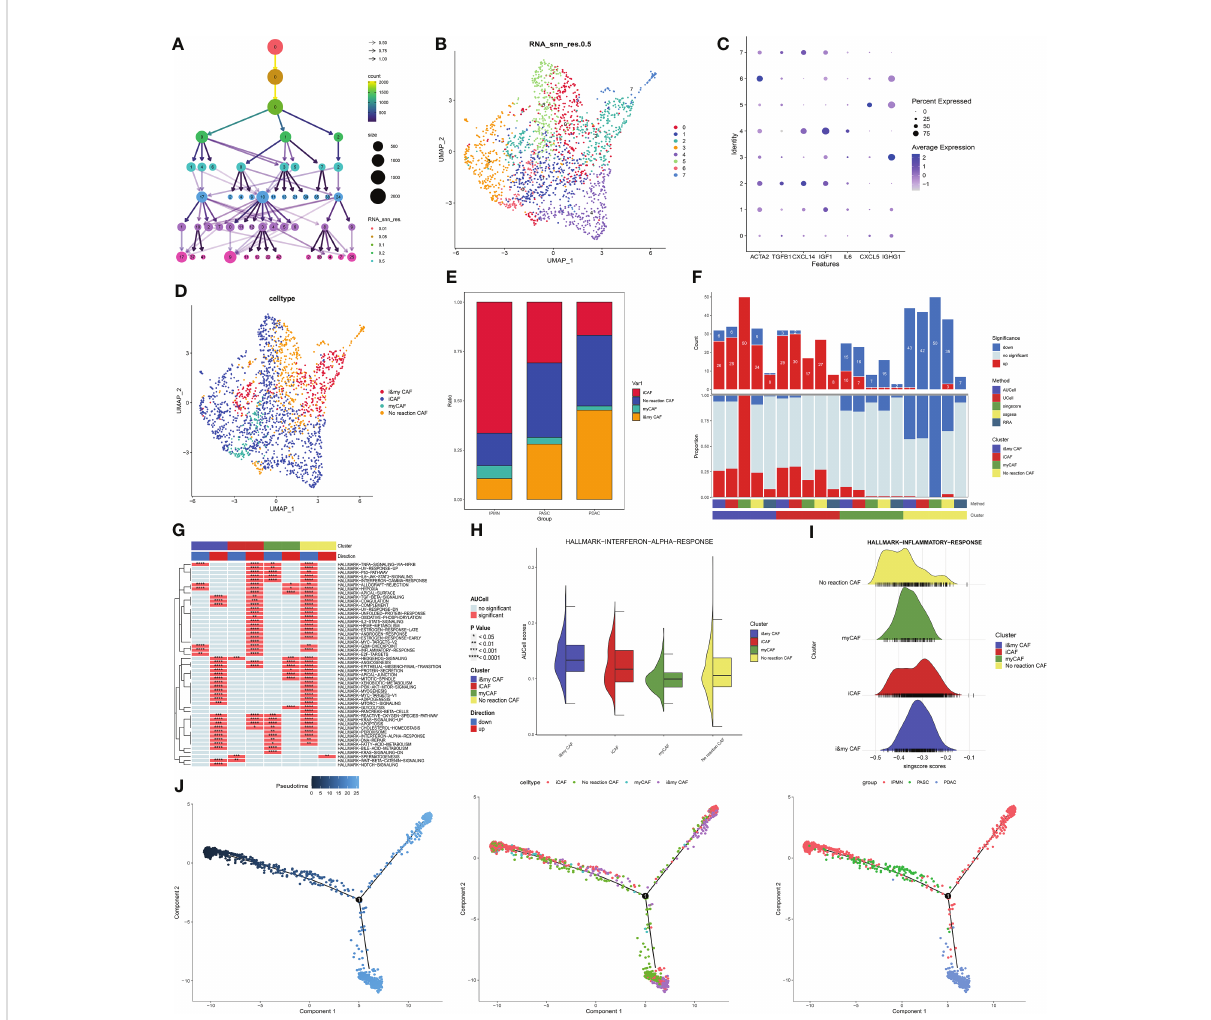
FIGURE 4 (A) Cluster tree of lymphocyte subgroup amounts at different resolution ratios. (B) UMAP cluster plot shows the divided subgroup before annotation. (C) Expression of each marker in each subgroup. (D) UMAP cluster plot shows the divided subgroup after annotation. (E) Bar graph of the proportion of each identi fi ed subgroup in each group. (F) Histogram showing the number of different enriched pathways in each identi fi ed subgroup. (G) GSVA plot showing the terms of different enriched pathways in each identi fi ed subgroup. (H) Gene set score of the interferon- a pathway. (I) Gene set score of the response to the in fl ammatory pathway. (J) Pseudotime analysis of these annotated groups in ASPC, IPMN, and PDAC. UMAP, Uniform Manifold Approximation and Projection; GSVA, gene set variation analysis; ASPC, pancreatic adenosquamous carcinoma; IPMN, intraductal papillary mucinous neoplasm; PDAC, pancreatic ductal